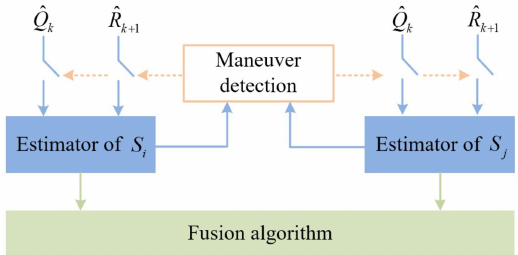
Figure 1. The framework of the noise-adaption